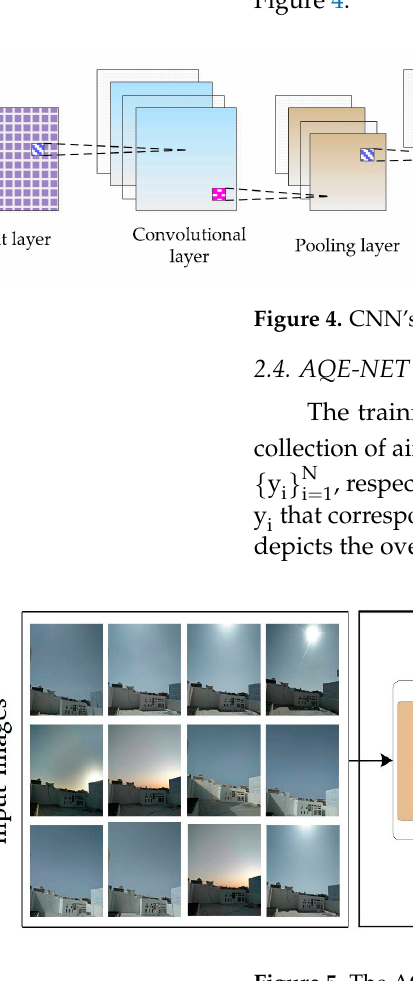
Figure 5. The AQE-Net model architecture for air quality index (AQI).